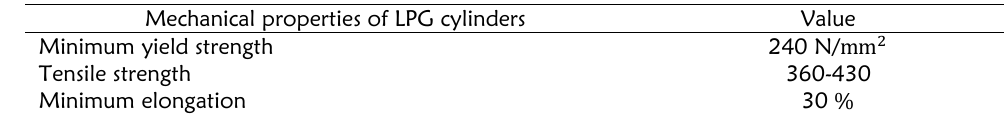
Table 1: Mechanical properties of LPG cylinders [10]